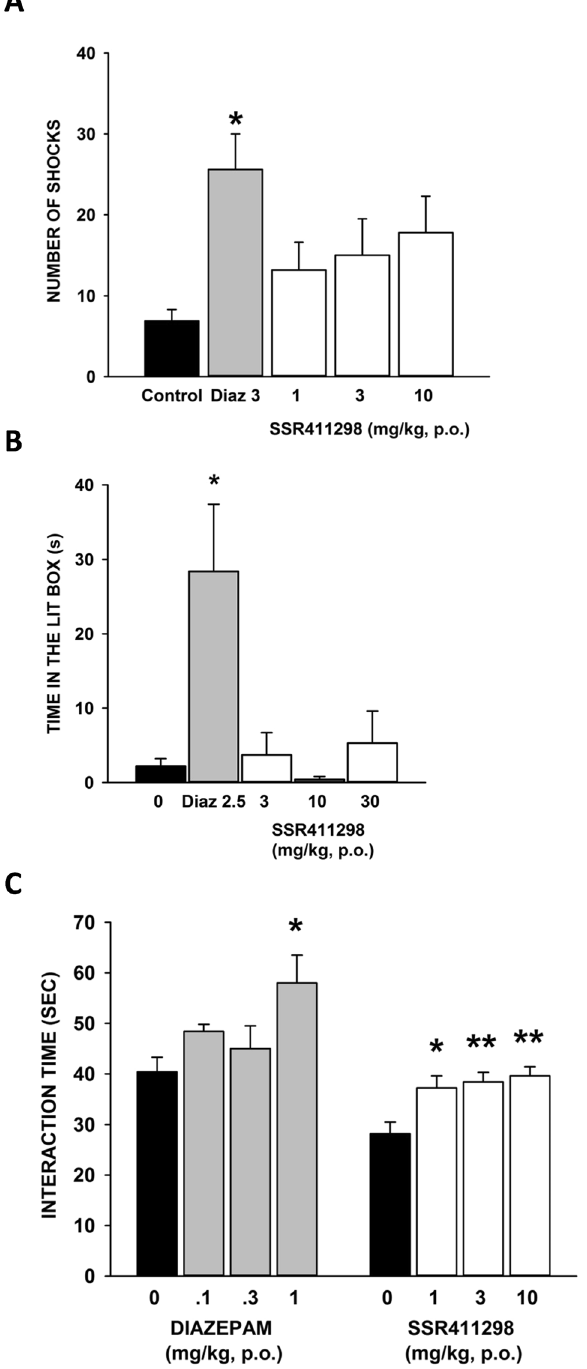
Figure 8. Effects of SSR411298 and diazepam in several classical models of anxiety, including the ( A ), punished drinking test in rats (N = 11–12 rats per group); ( B ) the light/dark test in mice (N = 11–12 mice per group) and ( C ), the social interaction in gerbils (N = 5 gerbils per group). Data represent mean + SEM, * P < 0.05, ** P <